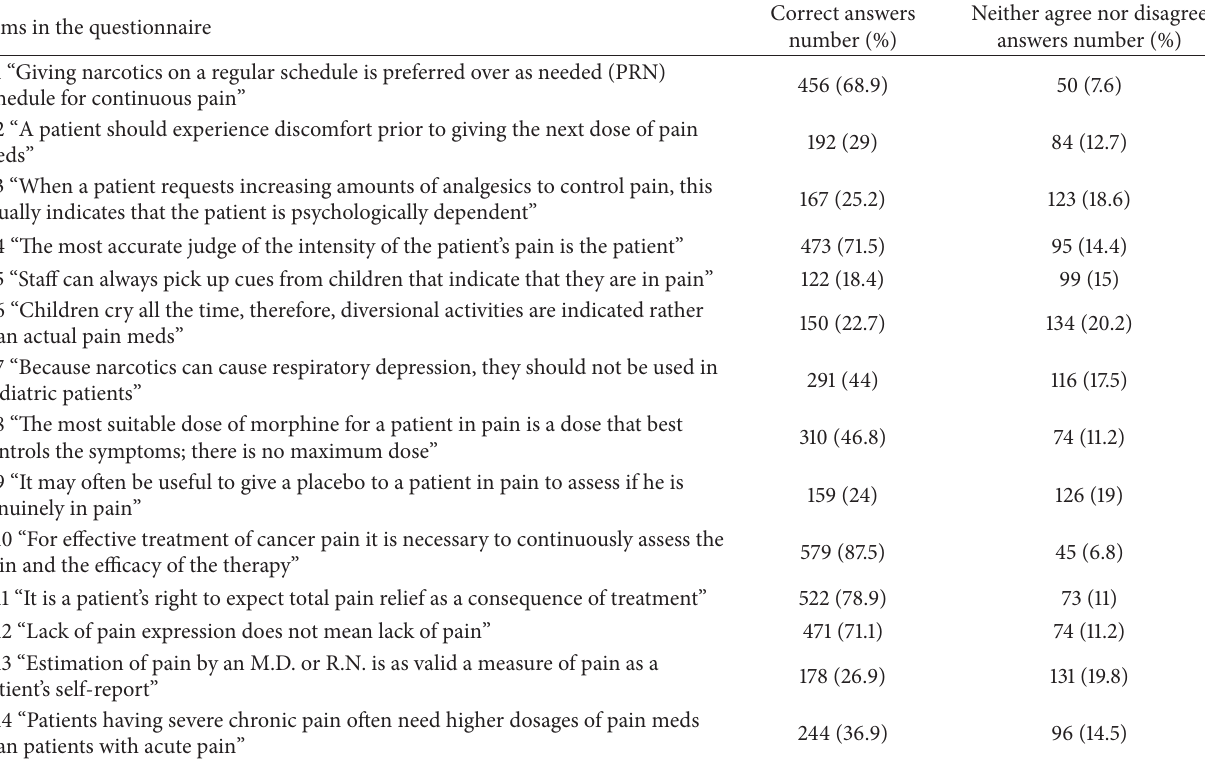
Table 2: Overview of the